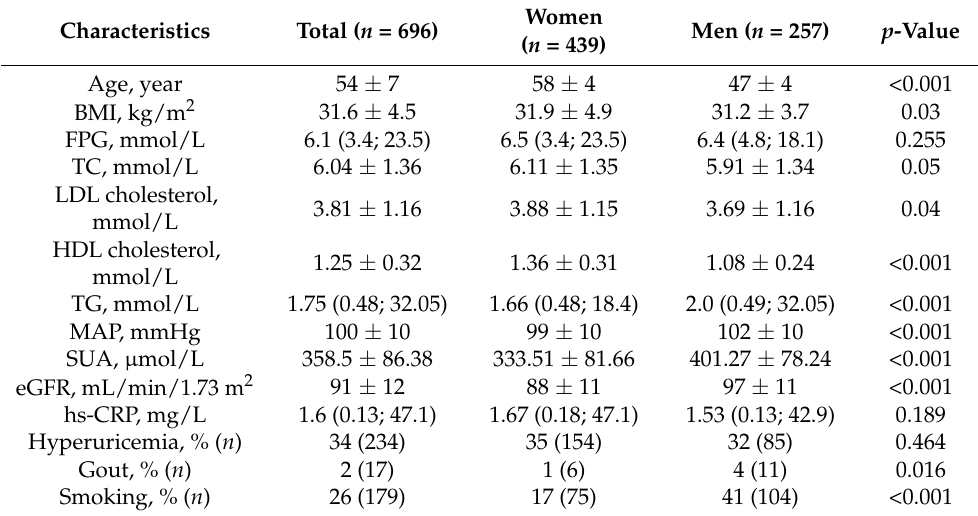
Table 1. Descriptive characteristics by sex.